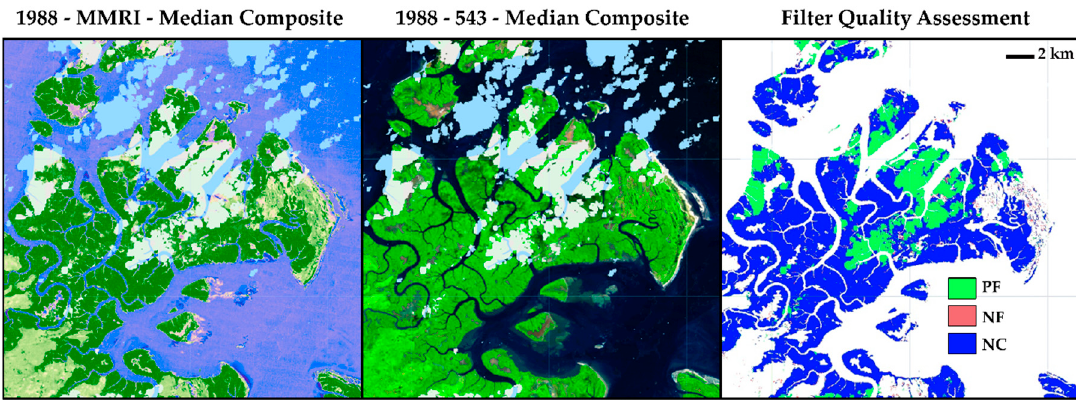
Figure 12. On the left is the 1988 MMRI median composite: dark green represents mangroves, light green is non-mangroves and blue is water. In the centre is the 1988 Landsat-5 band 543 median composite. On the right, PF denotes a positive filter (mangrove addition), NF stands for a negative filter (mangrove removal) and NC stands for no change. Table 3. Annual filter-affected area, in percentages. PF% indicates a positive filter (mangrove addition), PN% stands for a negative filter (mangrove removal) and NC% denotes an unfiltered pixel (no-change).